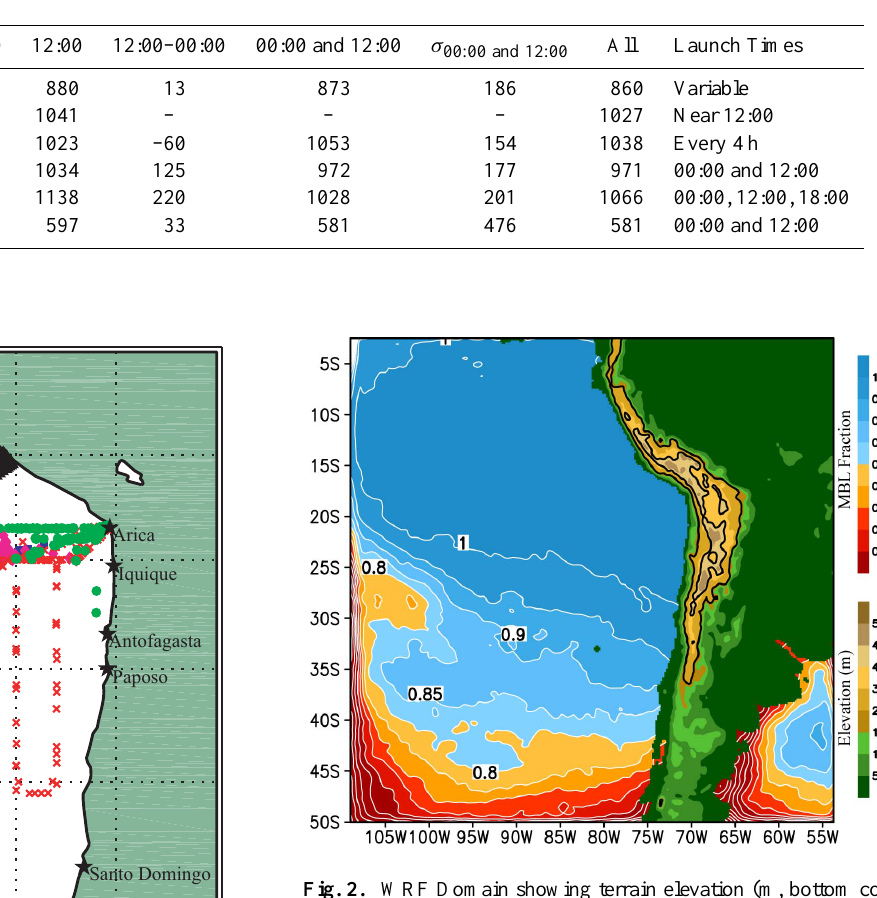
Table 1. Average MBL depth for various times including the difference between 12:00 and 00:00UTC, standard deviation, and launch times. All times in UTC and units in meters.